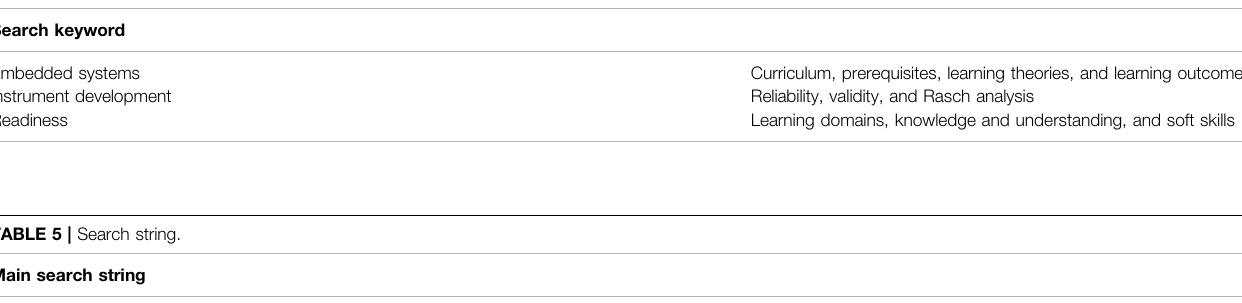
TABLE 5 | Search string. Main search string